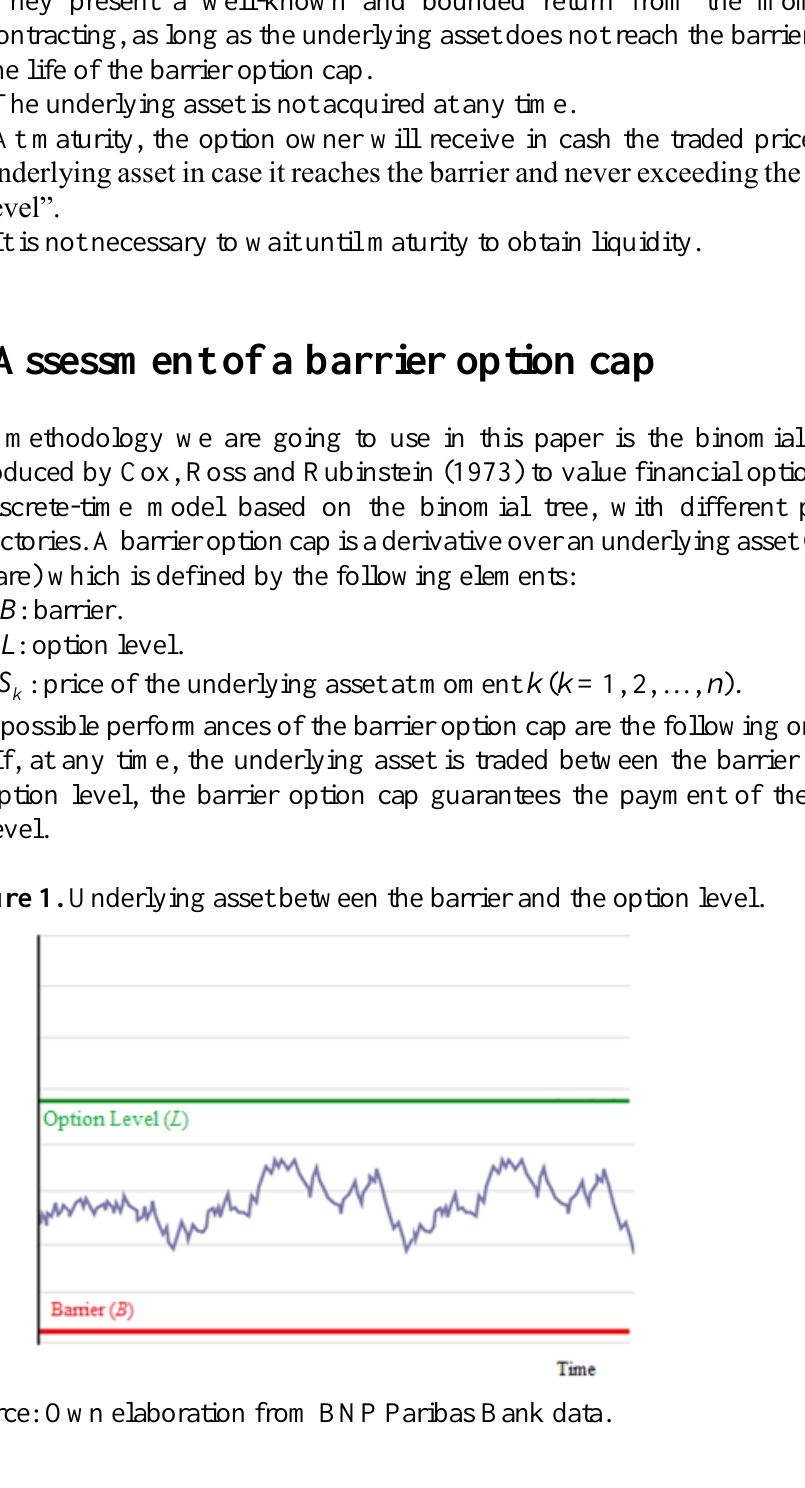
Source: Own elaboration from BNP Paribas Bank